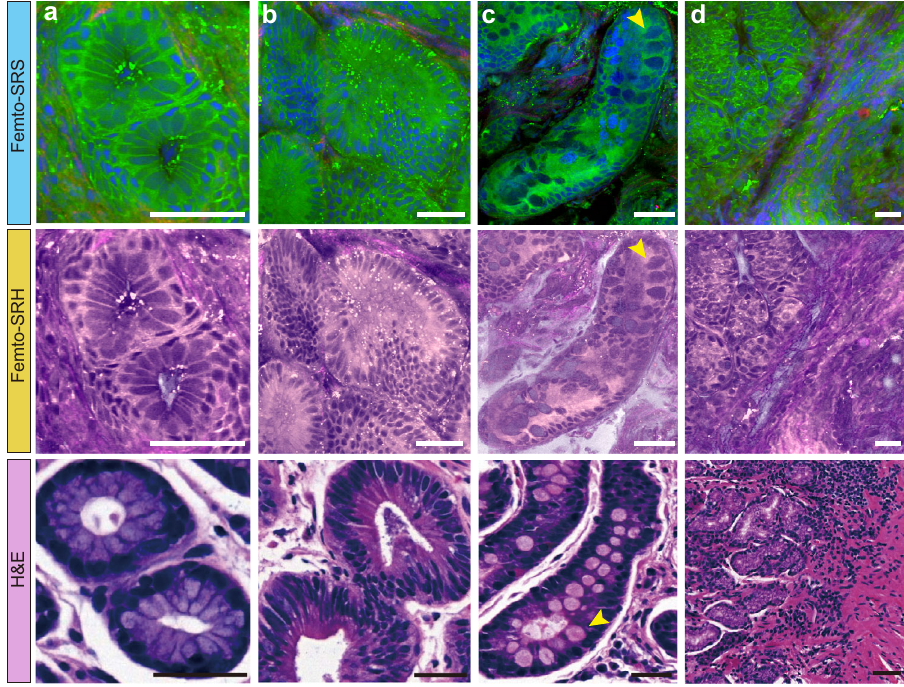
Fig. 3 Femto-SRS and femto-SRH reveal typical histopathological features of non-cancerous tissues. a Normal gastric gland; b Adenoma; c Intestinal metaplasia with the characteristic large cup-shaped cells (arrows); d Moderate mucosa in fl ammation. Green: lipids; blue: protein; red: collagen fi bers. Scale bars: 50 µ m. Source data are provided in the Source data fi